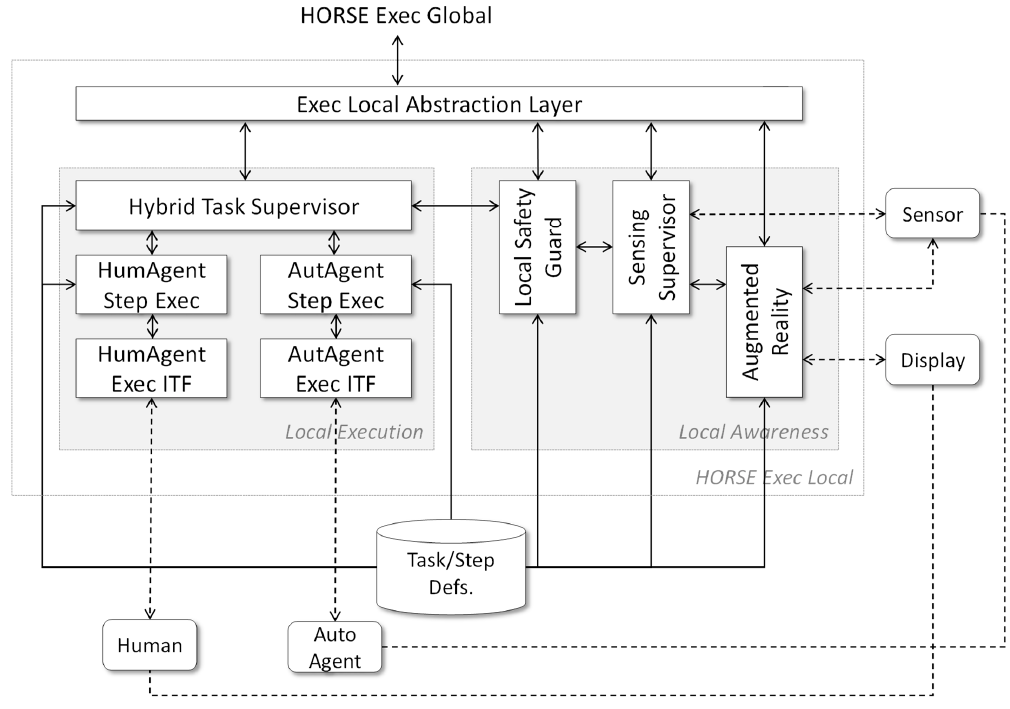
Figure 9. HORSE architecture, execution time aspect, aggregation level 3.